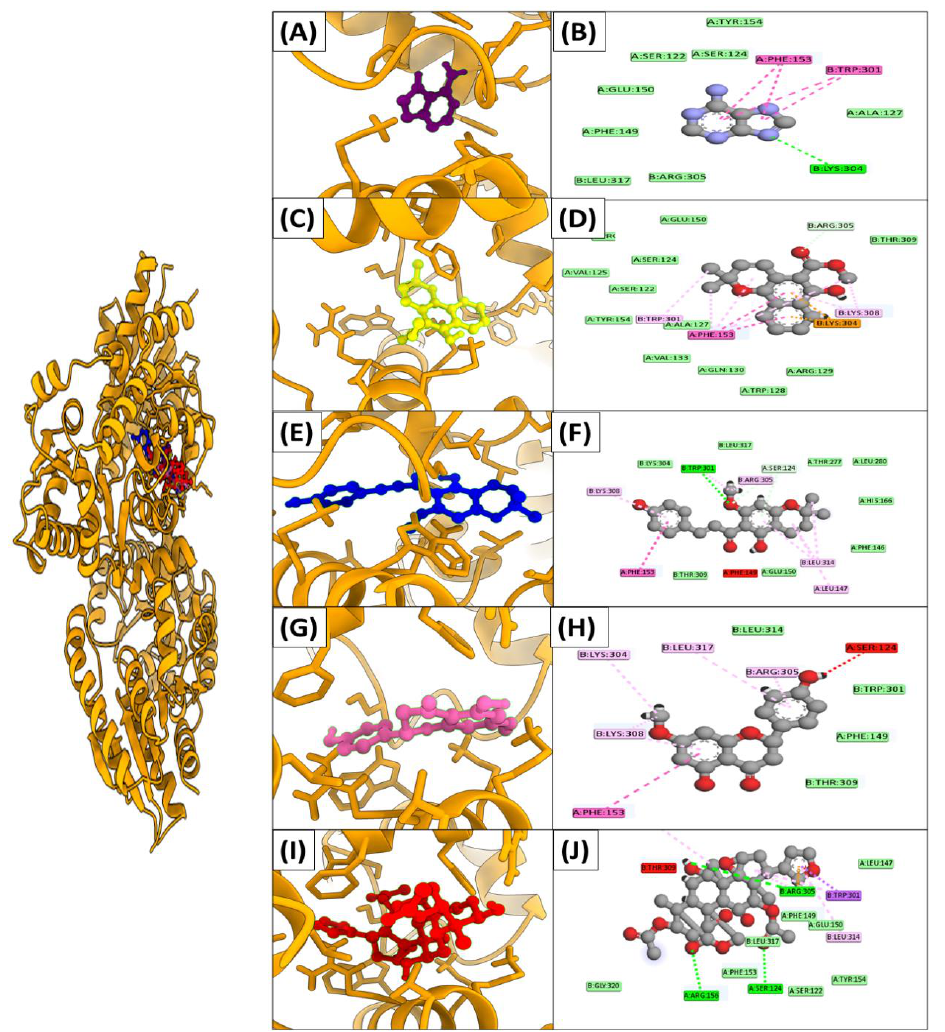
Figure 5. Interaction mechanisms and binding modes of novel lpxB protein inhibitors. A 3D close view into the binding mode of ( A ) Adenine, ( C ) Mollugin, ( E ) Xanthohumol C, ( G ) Sakuranetin, and ( I ) Toosendanin. 2D interaction analysis of ( B ) Adenine, ( D ) Mollugin, ( F ) Xanthohumol C, ( H ) Sakuranetin, and ( J ) Toosendanin.